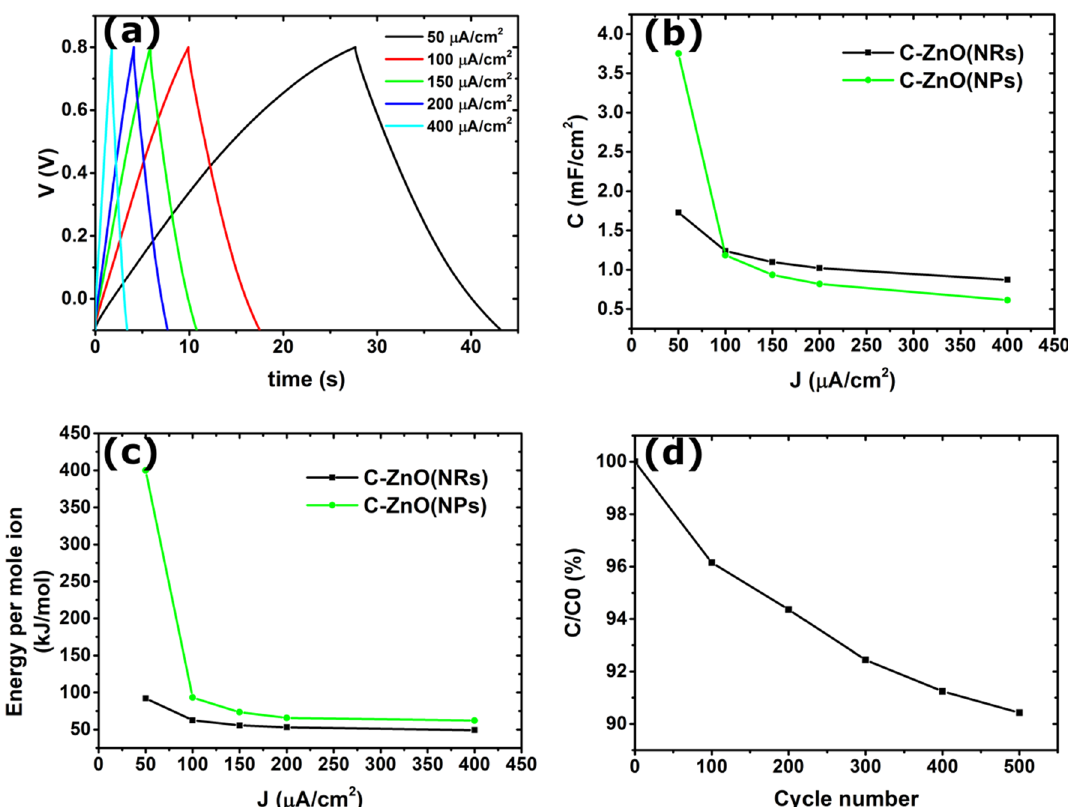
Figure 5. ( a ) CP curves for a C-ZnO(NRs) electrode at different charging/discharging current densities. The corresponding CP curves for a C-ZnO(NPs) electrode are shown in Fig. S4. ( b ) Integral areal capacitance versus current density for the C-ZnO(NRs) and C-ZnO(NPs) electrodes. ( c ) Calculated energy consumption per mole of Cl − in a NaCl electrolyte for C-ZnO(NRs) and C-ZnO(NPs) electrodes. ( d ) The ratio of integral